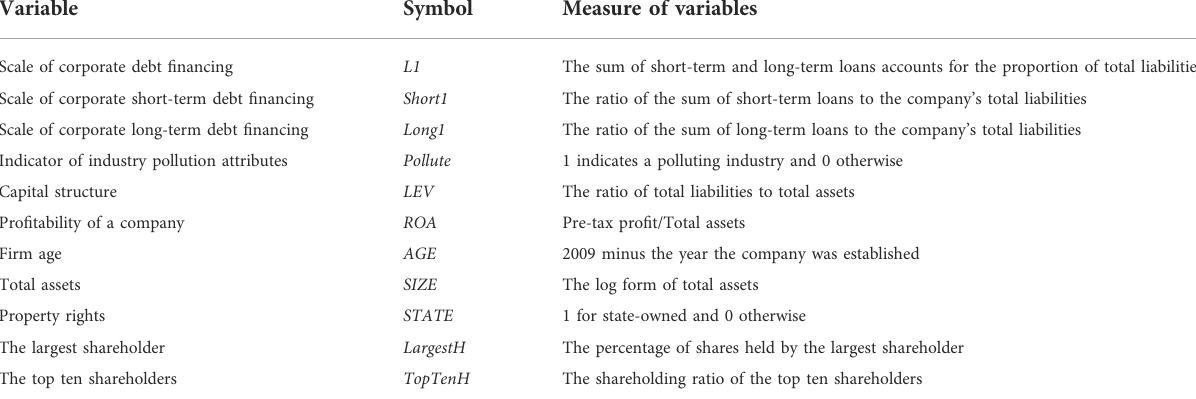
TABLE 1 De fi nitions of variables.